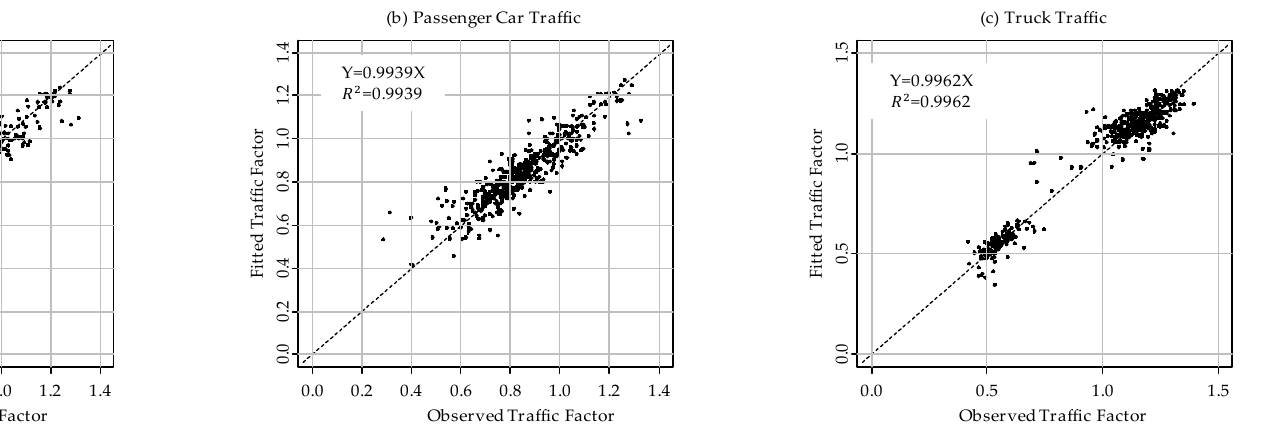
Figure 8. Fitted dummy variable regression modeling results at Red Deer Highway 2.